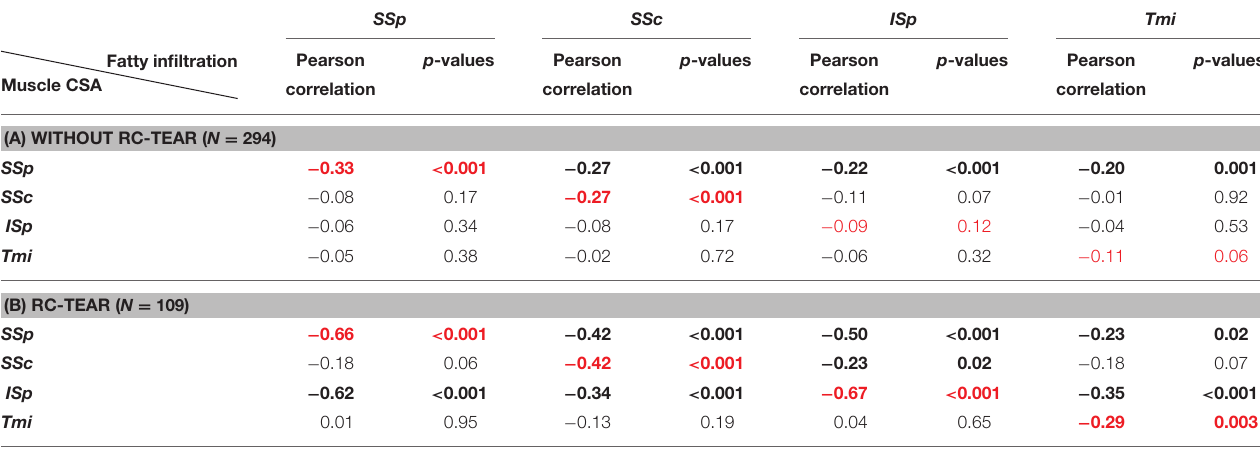
TABLE 2 | Correlations of muscle cross sectional area and fatty infiltration in the four RC muscles. SSp SSc ISp Tmi Fatty infiltration Pearson p -values Pearson p -values Pearson p -values Pearson p -values Muscle CSA correlation correlation correlation correlation